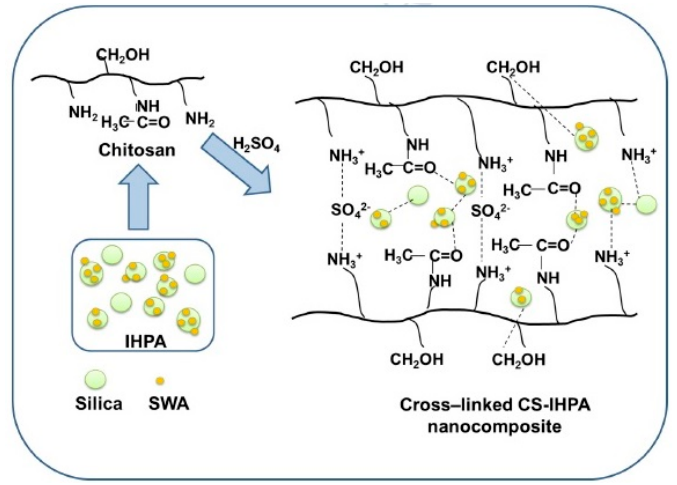
Figure 6. Schematic of the structure of crosslinked CS-silica-supported silicotungstic acid